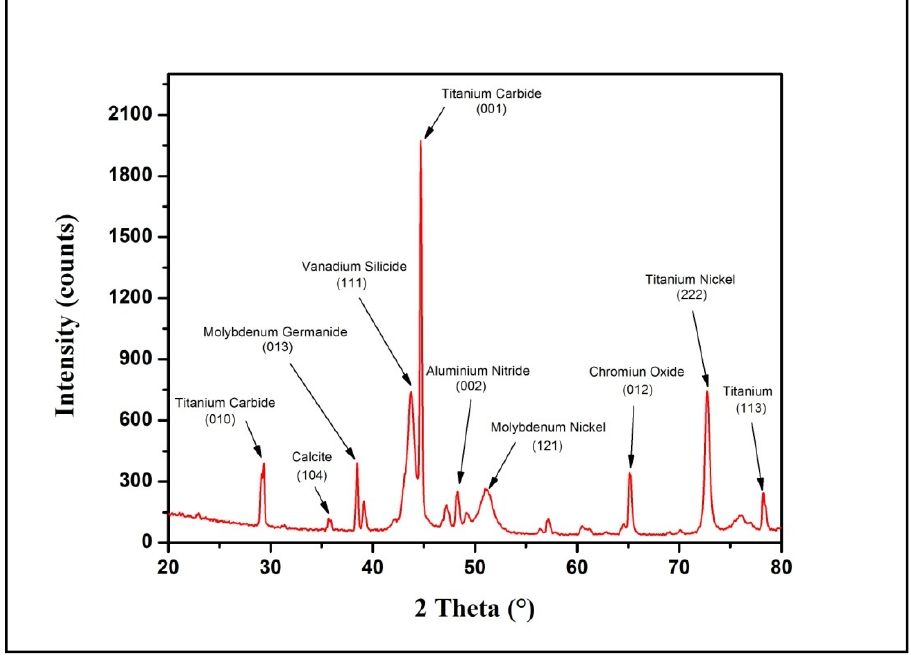
Figure 6. XRD spectra and crystallographic planes of MWCNTs treated sample (trial 17).